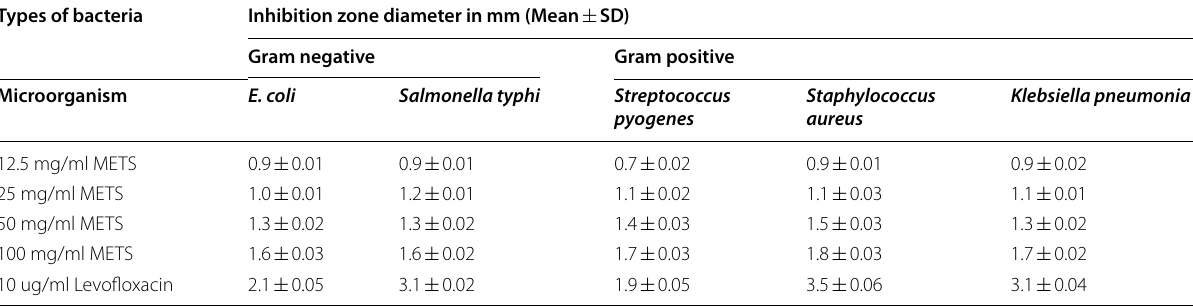
Inhibition zone diameter (mm). Volume of crude extract used (10 μl). Inhibition Zone diameter excludes the diameter of the well (7 mm)